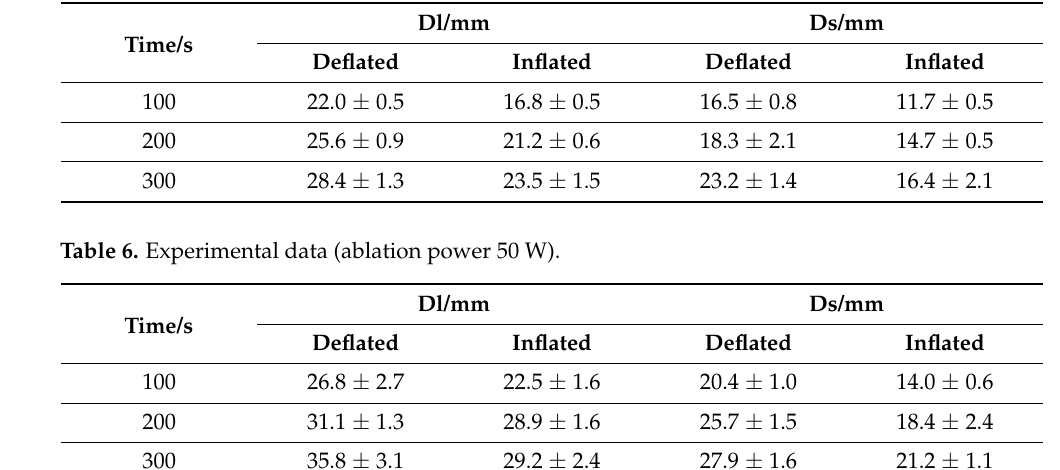
Table 5. Experimental data (ablation power 40 W).